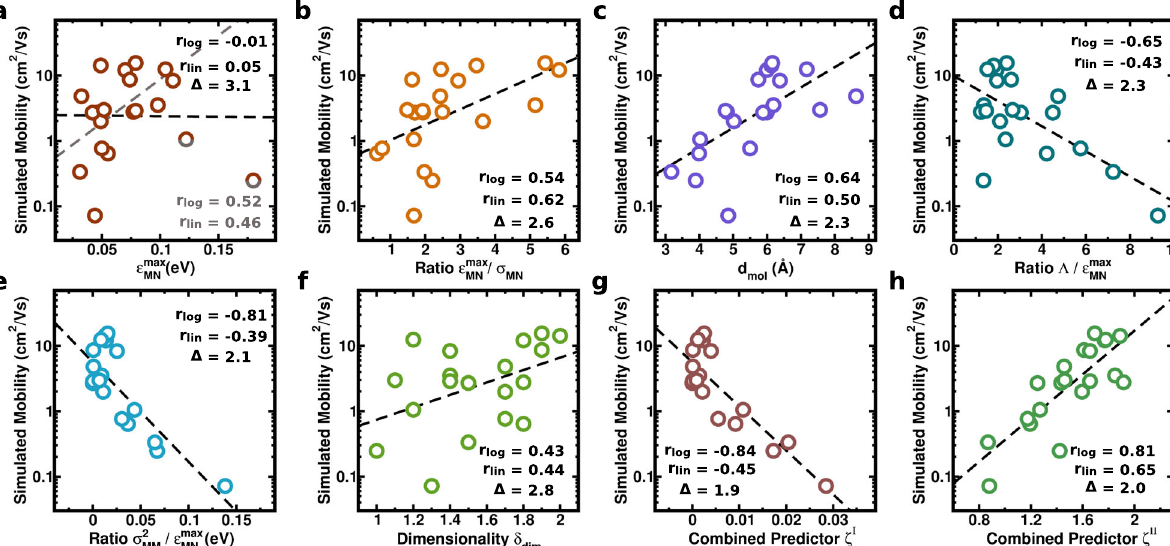
Fig. 5 Correlation between material parameters and the simulated mobility. We present the correlation coef fi cient with respect to the logarithmized mobility ( r log ) and the original data ( r lin ). The black dotted line is a linear fi t between the studied material parameter and logarithmized mobility, while Δ is the average deviation from this fi t. The fi t details and fi t parameters can be found in Supplementary Note 3. a shows the dependency of the simulated mobility on the maximum transfer integral ε max . Here, a second fi t is performed by hypothetically MN neglecting two outliers (gray half circle), leading to the correlation shown in gray. The further studied parameters are b the ratio between the maximum transfer integral ε max and its nonlocal disorder σ MN , c the molecular center-of-mass distance in the direction of the largest transfer MN integral d mol , d the ratio between th e reorganization energy Λ and transfer integral ε max , e the ratio between the local disorder σ 2 and MN MM transfer integral ε max , and f the dimensionality δ dim . The last plots show combinations of the previous predictors: the combined predictor ζ I in MN g , and fast-to-calculate combined predictor ζ II in h